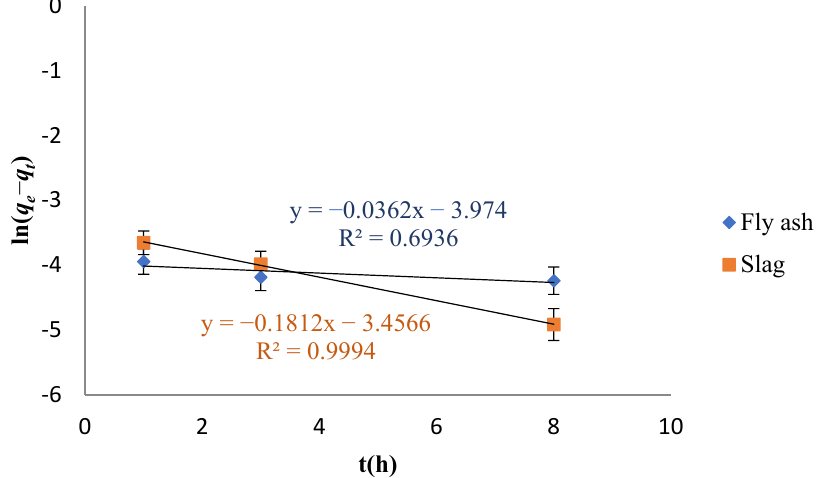
Figure 6. Pseudo-first-order linear kinetic model of Cs adsorption on the fly ash-based geomaterials and slag-based geomaterials.